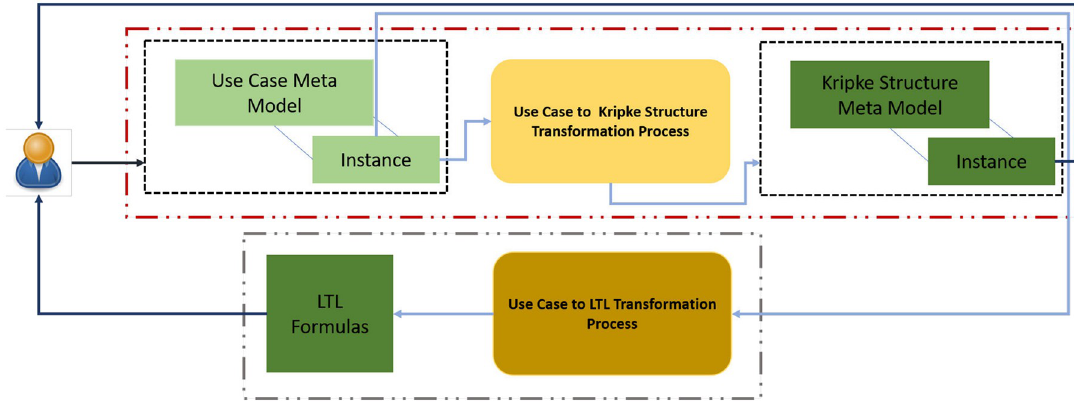
Fig 1. Proposed approach schematic